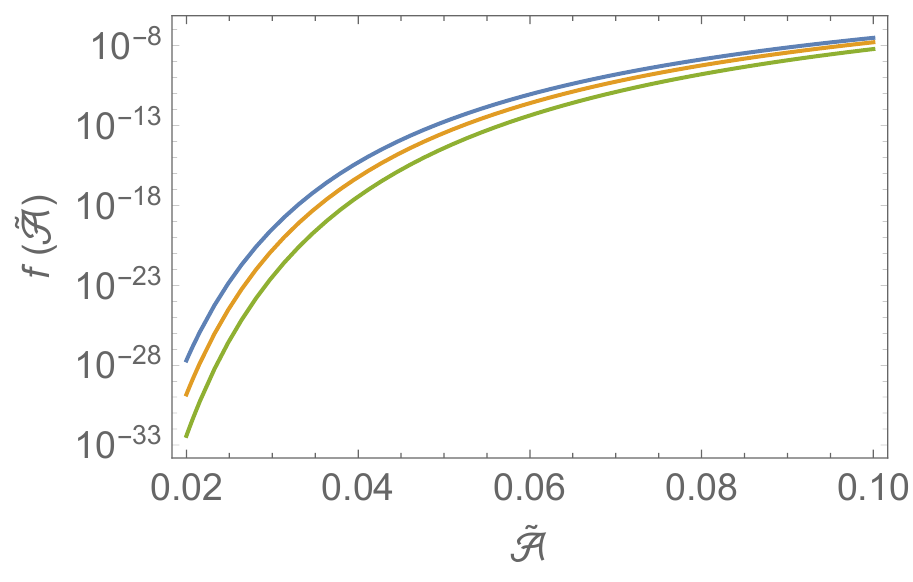
Figure 4 . The function f ( e A ). We have taken ~ r min = 0 : 1 ; 0 : 2 and 0 : 3 from top to